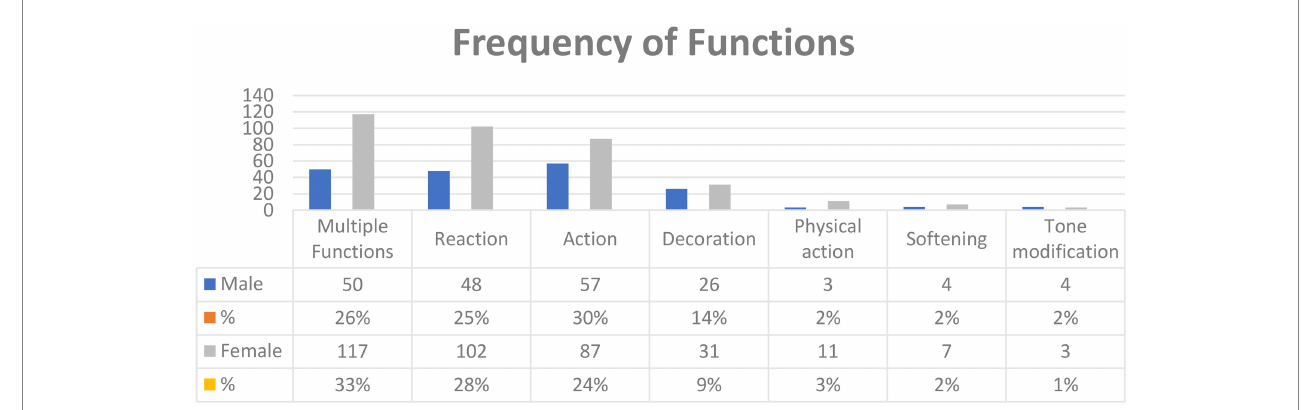
FIGURE 3 The frequency of functions in Arabic tweets.